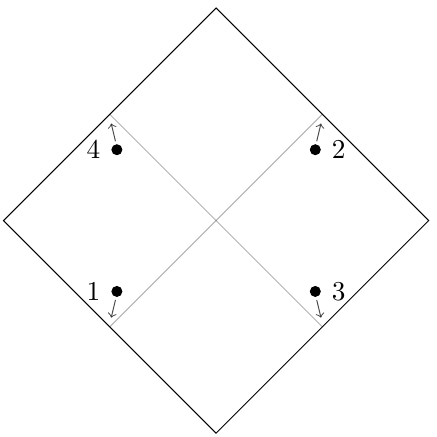
Figure 1. The Regge limit of a four-point function: the points x 1 ; : : : ; x 4 approach null in(cid:12)nity, with the pairs x 1 ; x 2 and x 3 ; x 4 becoming nearly lightlike